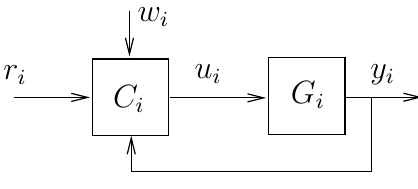
Figure 2. General feedback control loop of each